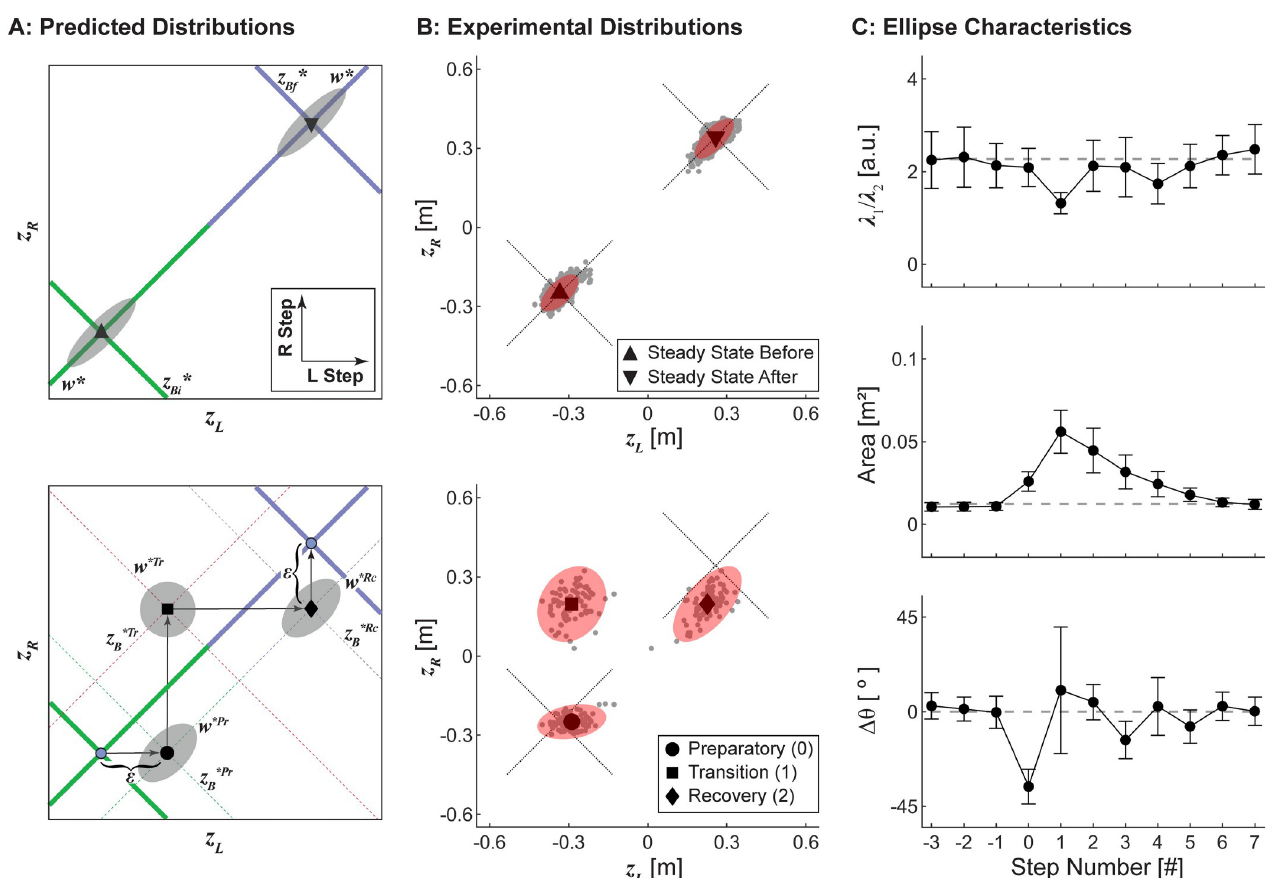
Fig 5. Experimental Stepping Distributions. A) Predicted stepping goals and distributions for the experimentally-imposed lane-change maneuver during both the steady-state walking periods (top) and transition steps (bottom). During steady-state walking before and after the maneuver, we predicted stepping distributions would be strongly aligned to the w � GEM, reflecting strong prioritization of step width over position regulation, as we have previously observed [1]. Participants most commonly performed the maneuver using a four-step maneuver strategy (Fig 2), which included 3 intermediate steps with distinct stepping goals. Stepping distributions were predicted to be most isotropic at the large primary transition step, and intermediately isotropic at the smaller preparatory and recovery steps. B) Experimental stepping data during the steady state periods before and after the transition (top) and during the preparatory, transition, and recovery steps from 78 analyzed maneuvers, plotted to appear from left to right (bottom), projected onto the [ z L , z R ] plane. The steady-state data were pooled across 16 steady-state steps before and after the transition from 20 participants performing 4 transitions each (1280 steps total). The diagonal dotted lines indicate the initial and final constant- z B � and constant- w � GEMs. The gray dots indicate individual steps, and the red ellipses depict 95% prediction ellipses derived using a χ 2 distribution. C) Experimental 95% prediction ellipse characteristics at each step: aspect ratio (top), calculated as the ratio of the eigenvalues of the covariance matrix of the ellipse, area (center), and orientation (bottom), calculated as the angular deviation (positive angles indicate counter-clockwise) from the orientation of the constant- w � GEM. Error bars indicate ± 95% confidence intervals at each step derived using bootstrapping. Gray dashed lines indicate the mean of each characteristic from the two steady state ellipses in (B;